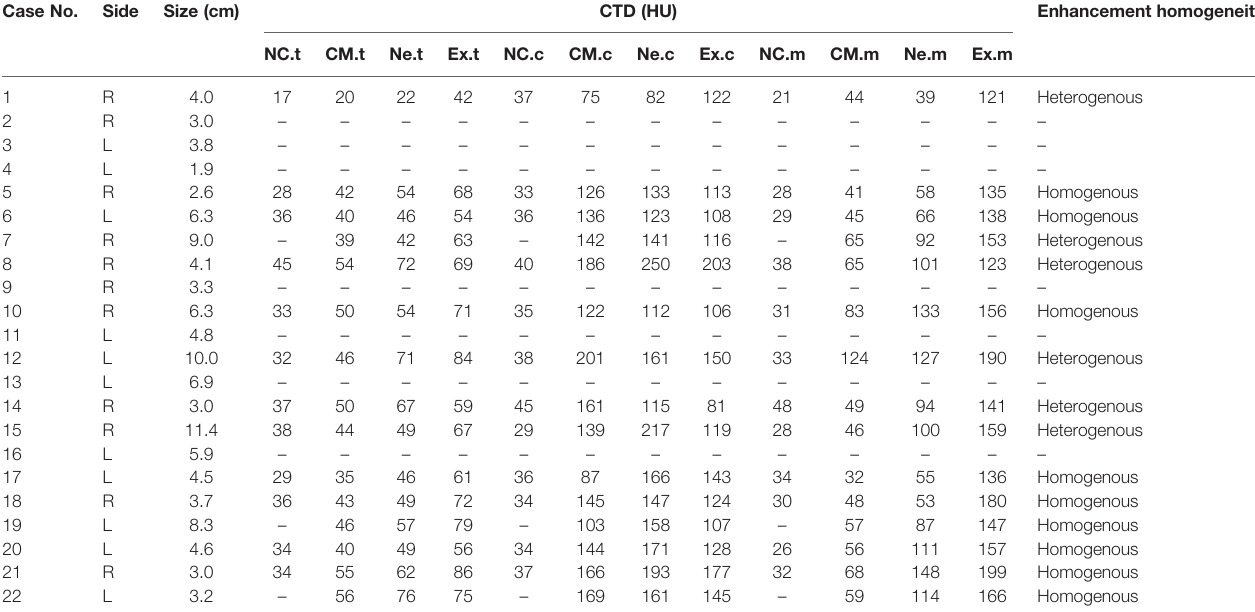
TABLE 3 | CT characteristics of primary tumor. Case No. Side Size (cm) CTD (HU)